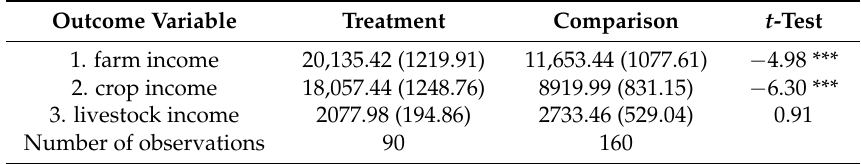
Table 2. Distribution of average values (birr) of outcome variables in the study sample.